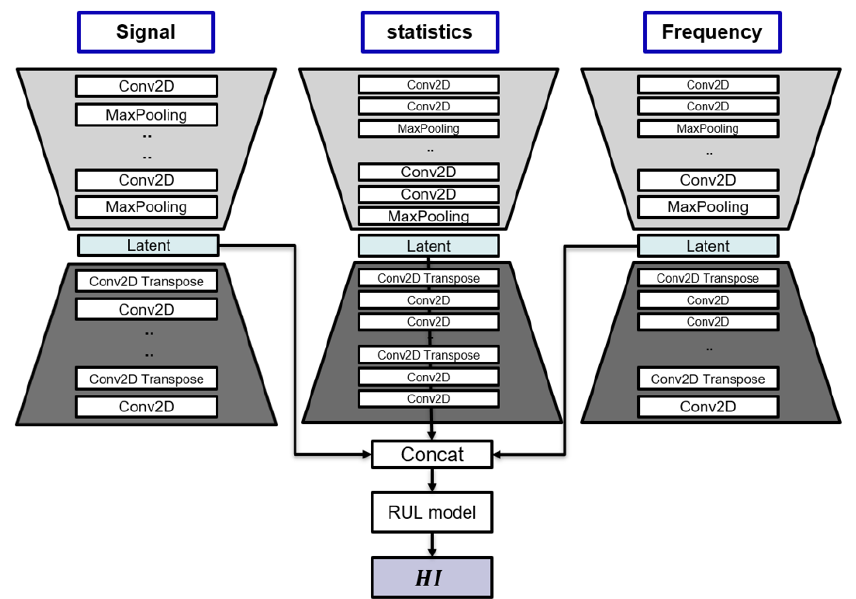
Figure 7. Network model of one-stage feature ensemble autoencoder for estimating RUL.